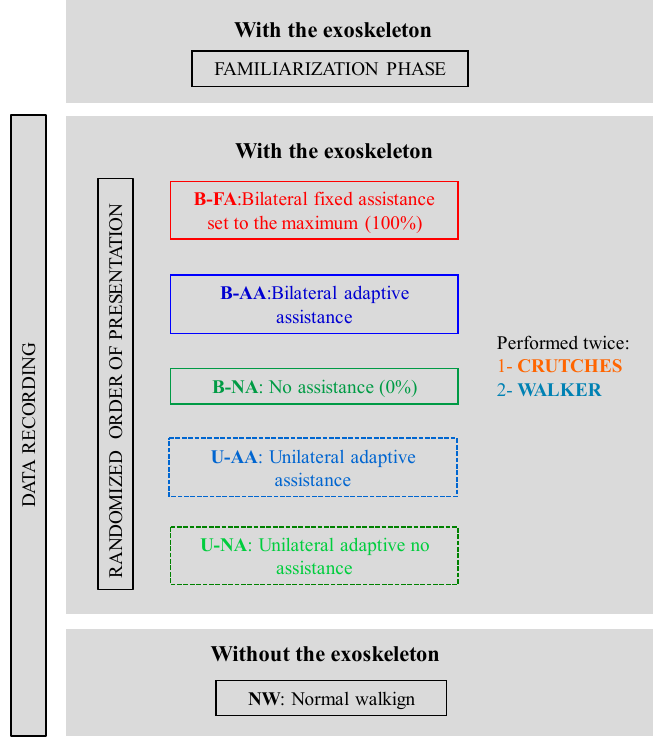
Figure 2. Experimental protocol.